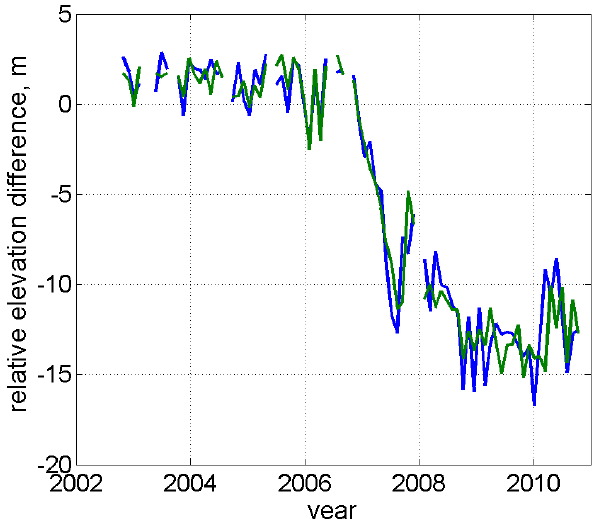
Fig. 9. Relative elevation time series from Envisat radar altimetry over Lake Cook E2 at two adjacent locations along track. The two time series are taken at the same location as series in Fig. 4; only the processing differs. Here, all data are used in the processing, whereas in Fig. 3 only the data acquired before the start of the drainage were used. Note the larger noise level